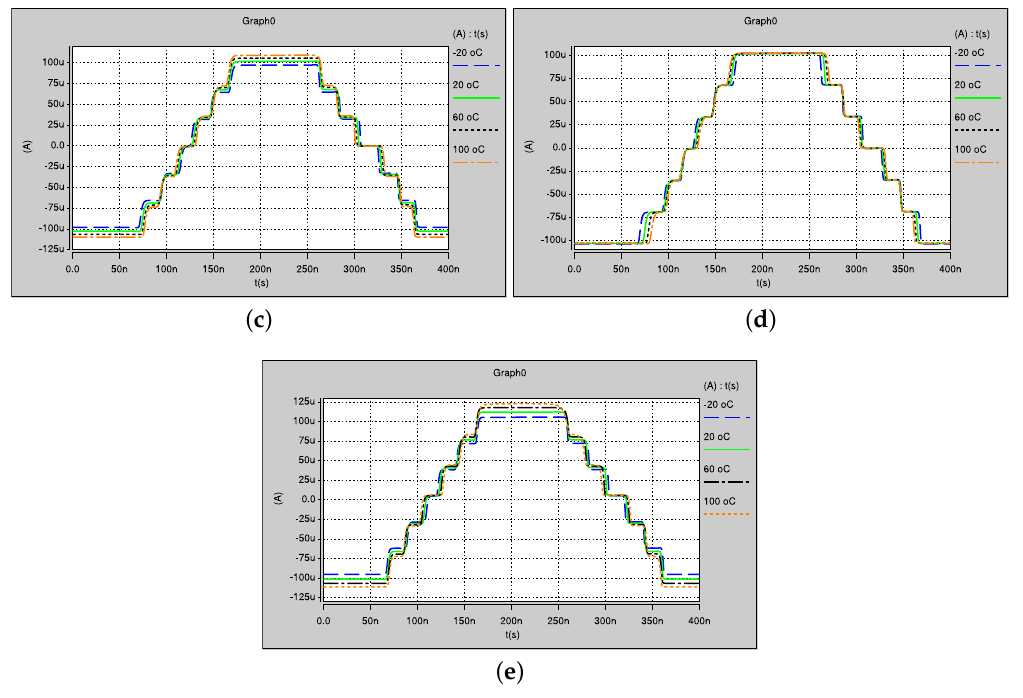
Figure 15. Temperature variations of the proposed PWL function in time simulation to generate seven-scroll: ( a ) TT; ( b ) SF; ( c ) FS; ( d ) SS; and ( e ) FF